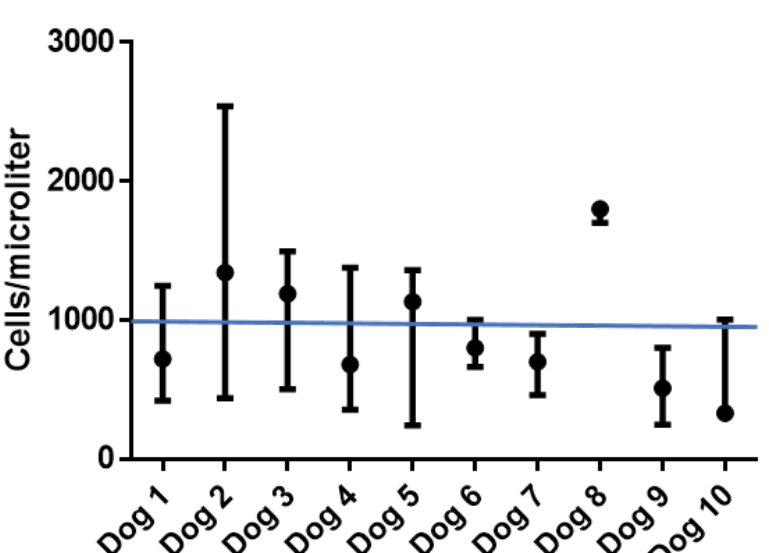
Figure 4. Variation in lymphocytes/microliter of blood. Circles indicate the median and error bars indicate the range of lymphocytes/microliter observed for each dog during the course of the study. The straight line at 1000 cells/microliter represents the low value of the reference interval for lymphocyte concentrations in healthy dogs.